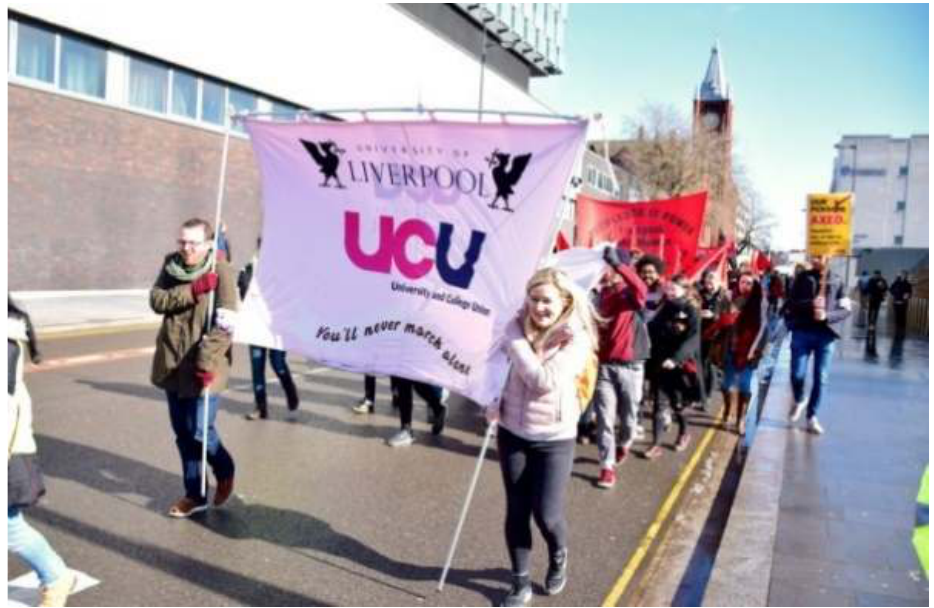
Figure 12. Staff and students march through Liverpool, March 8,